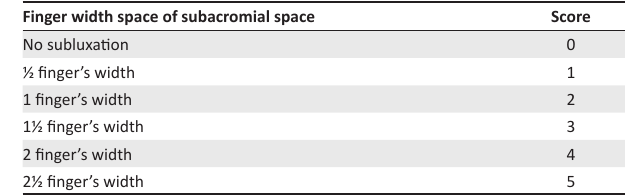
TABLE 1: Finger width measurement of shoulder subluxation.